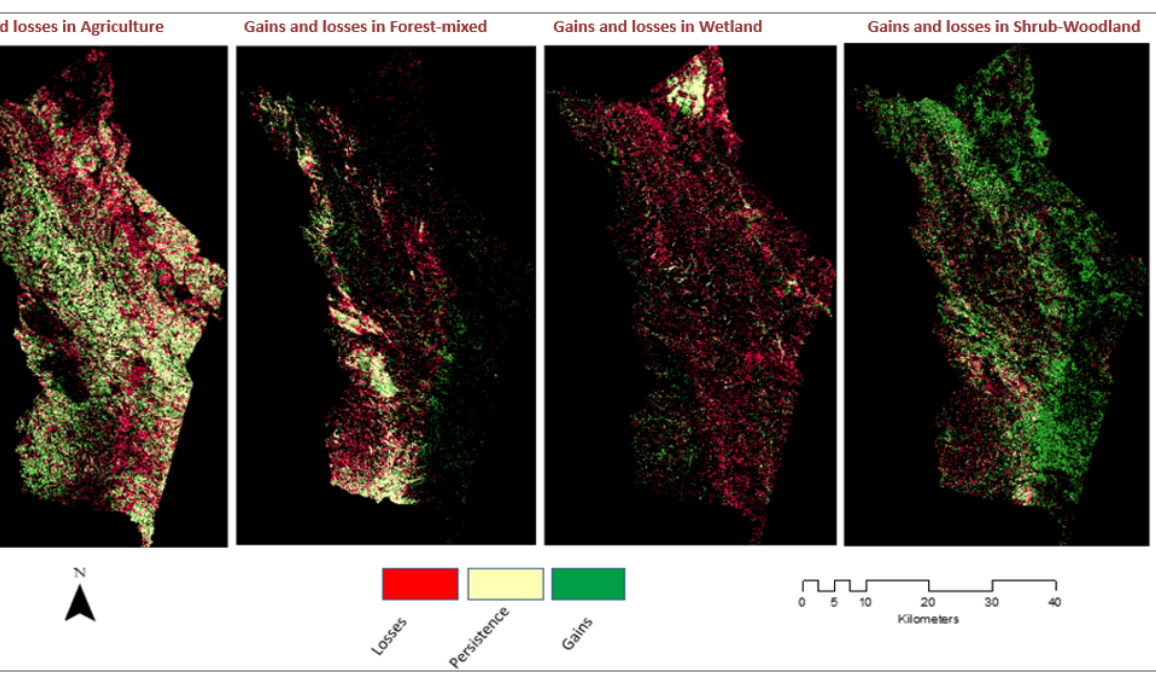
Figure 7. Maps of land gains, persistence and losses change classes from agriculture, forest-mixed wetland, shrub-woodland classes in Ntcheu district (2001–2019 period).